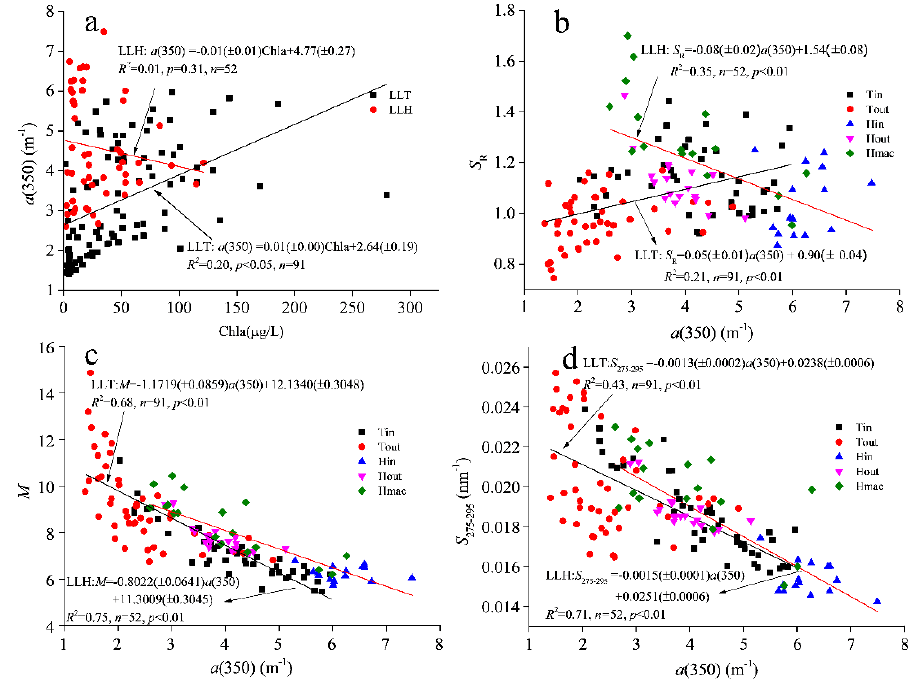
Figure 3. Mutual correlations between CDOM absorption a (350) and Chla ( a ), S R ( b ), the M value ( c ) and S 275–295 ( d ).